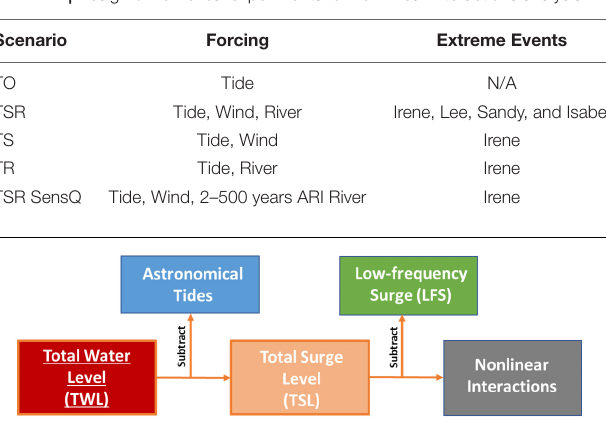
TABLE 1 | Design of numerical experiments for non-linear interactions analysis.